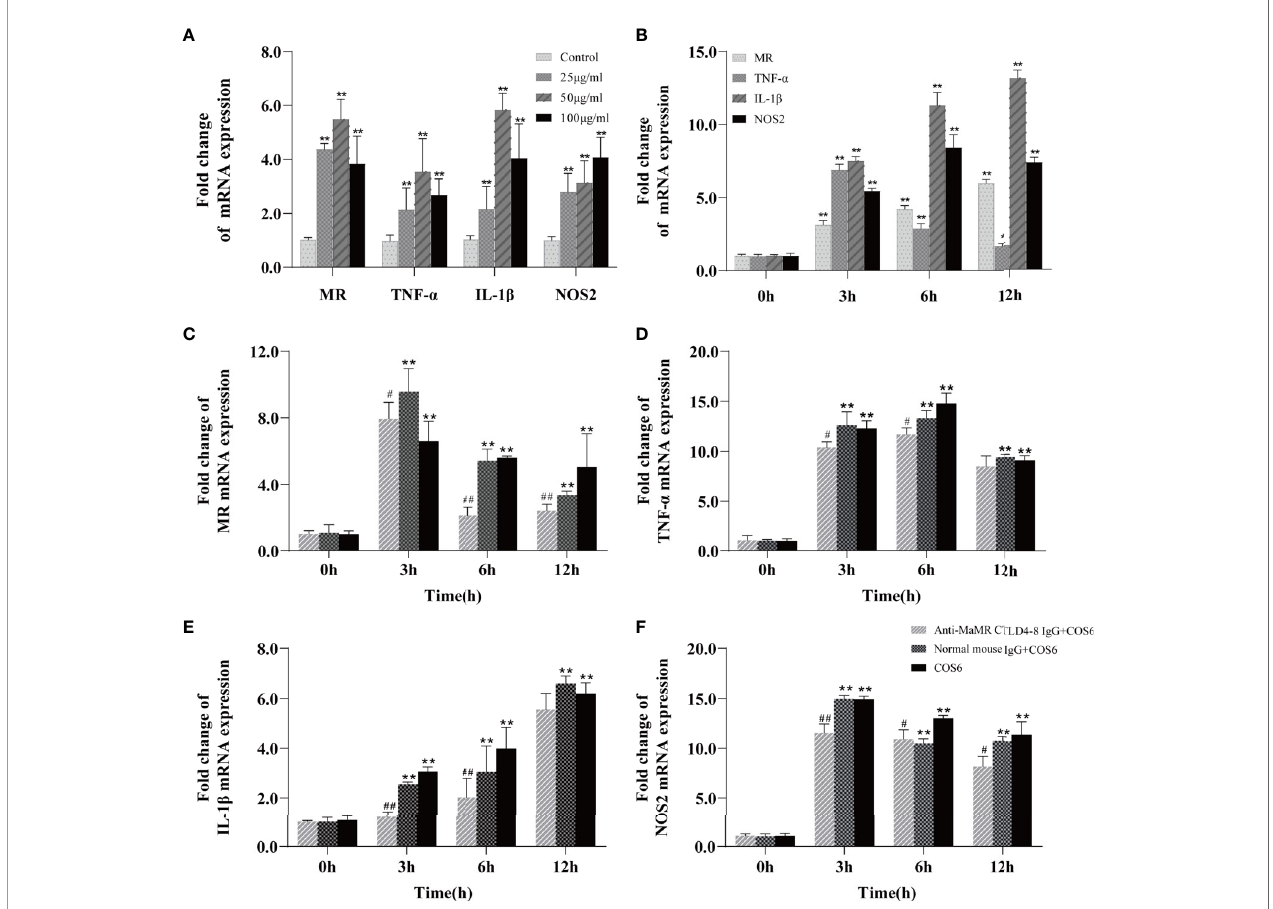
FIGURE 1 | qRT-PCR analysis of the expression of mannose receptor (MR) and in fl ammation-related genes induced by chitooligosaccharide hexamer (COS6) in macrophages. (A) Gene expression in macrophages stimulated by COS6 for 6 h in 25, 50, and 100 m g/ml. (B) The macrophage gene expression was stimulated with 50 m g/ml COS6 at 0, 3, 6, and 12 h. Pre-blocking cells with or without anti-mannose receptor C-type lectin-like domain 4-8 of Megalobrama amblycephala (MaMR CTLD4-8) antibody, and the expression patterns of MR (C) , tumor necrosis factor (TNF)- a (D) , interleukin (IL)-1 b (E) , and nitric oxide synthase (NOS)2 (F) were determined. The samples were analyzed at 0, 3, 6, and 12 h after 50 m g/ml COS6 stimulation. b -Tubulin was used as an internal reference. Each experiment was executed in triplicate. Data were shown as means ± SD (n = 3), with (*) p < 0.05 and (**) p < 0.01 vs. the 0 m g/ml or 0 h, ( # ) p < 0.05 and ( ## ) p < 0.01 vs. the COS6 group (set as